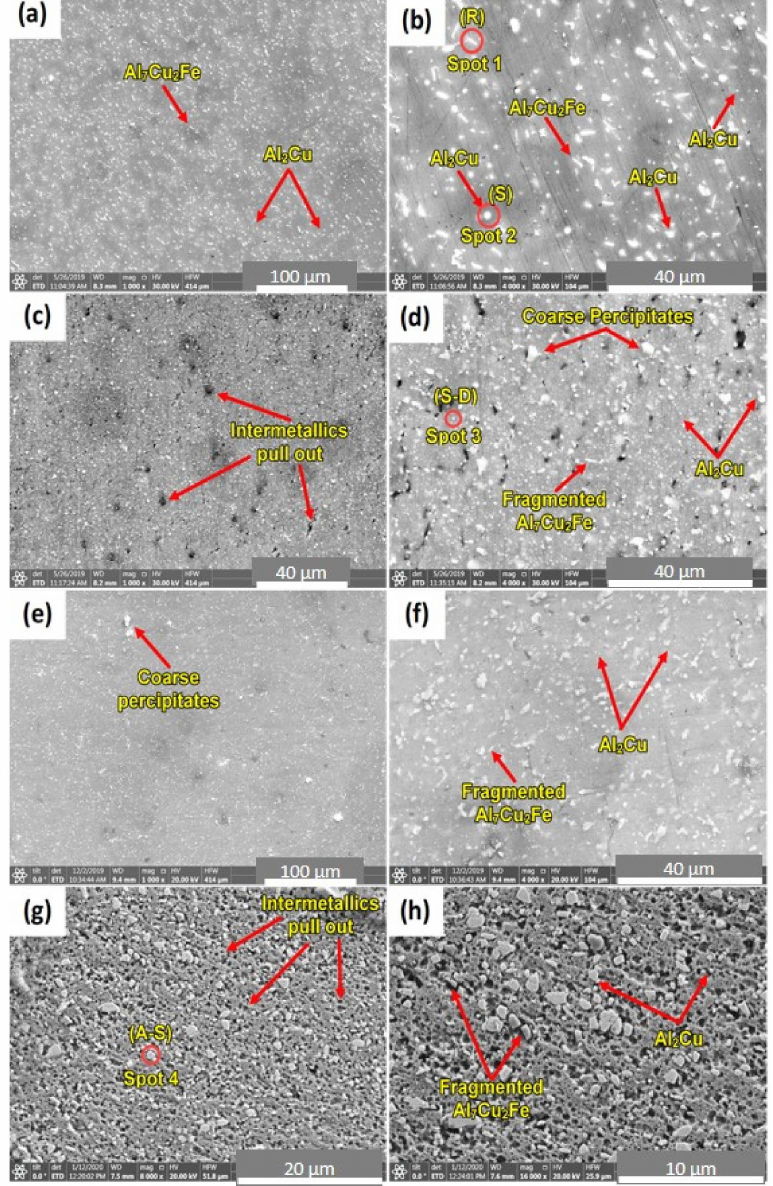
Figure 8. Low and high-magnification SEM micrographs of ( a , b ) AA2011-T6 base alloy, ( c , d ) FSDed of AA2011-T6 at 1200 rpm—3 mm/min, ( e , f ) FSDed AA2011-T6 at 1200 rpm—6 mm/min, and ( g , h ) FSDed AA2011-O at 200 rpm—1